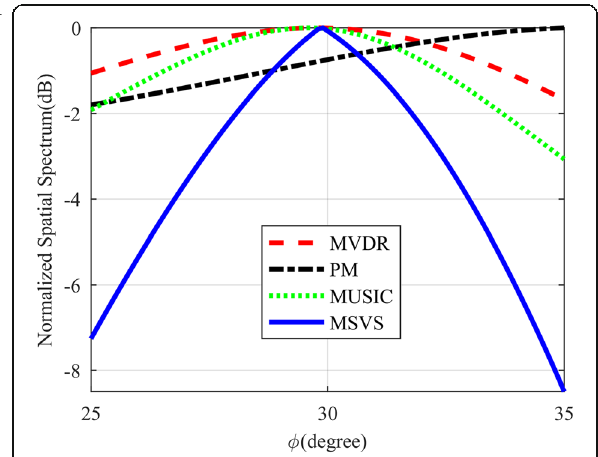
Fig. 4 Spatial spectra comparison, SNR = − 15 dB, N =